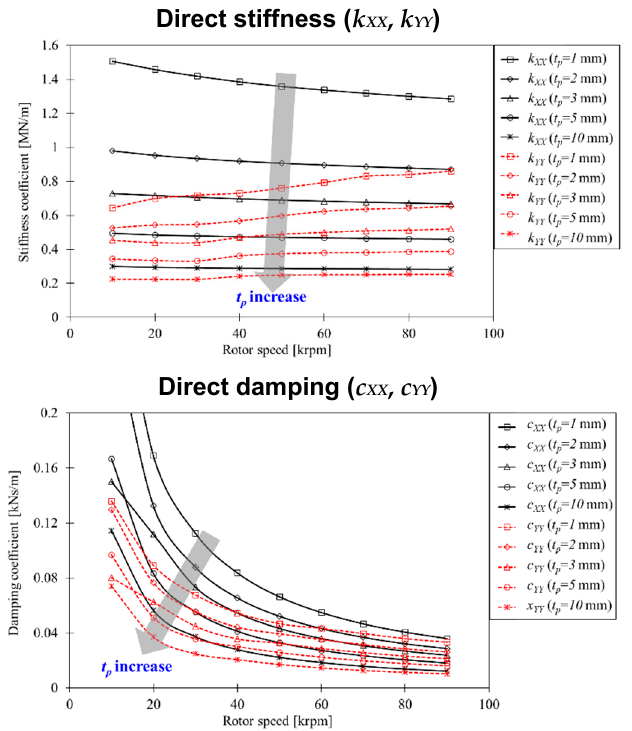
Figure 9. Predicted synchronous force coefficients versus the rotor speed depending on the polymer layer thickness: direct stiffness coefficients and direct damping coefficients.